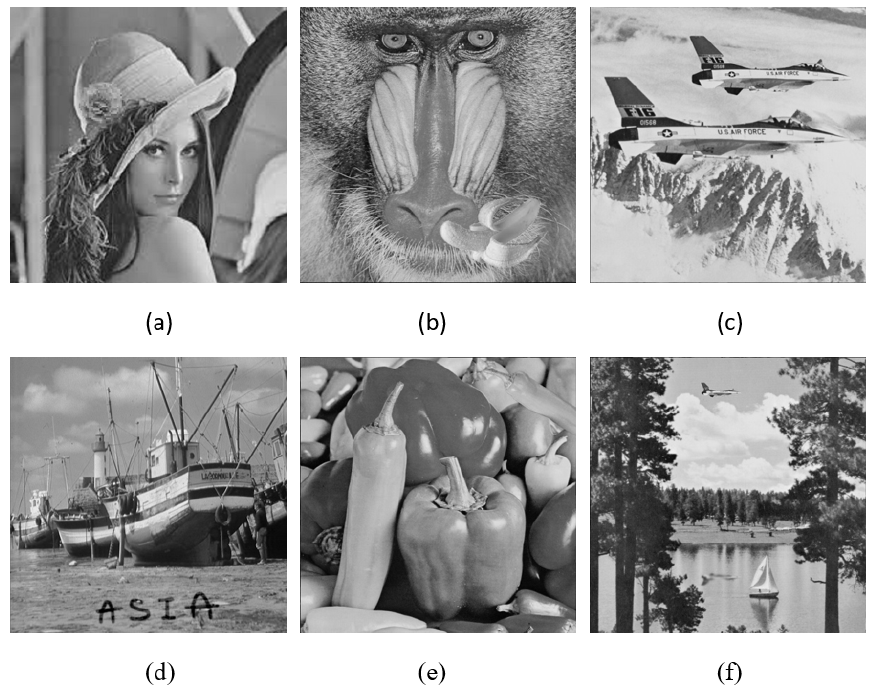
Figure 17. Tampered images. ( a ) Lena, ( b ) Baboon, ( c ) Jet, ( d ) Boat, ( e ) Pepper, ( f ),